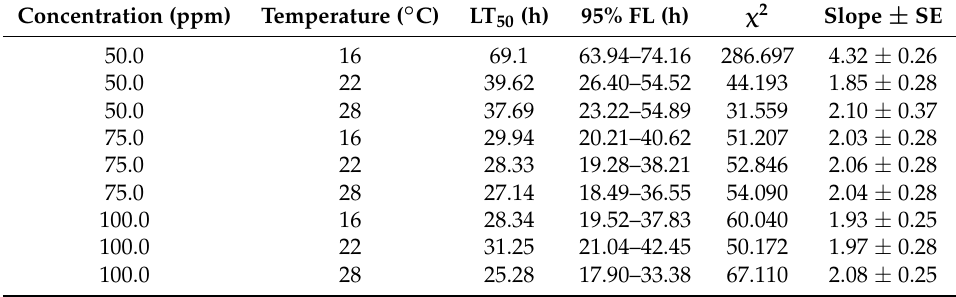
Table 4. Effect of concentration and temperature on mortality of Formosan subterranean termites, C. formosanus , exposed to